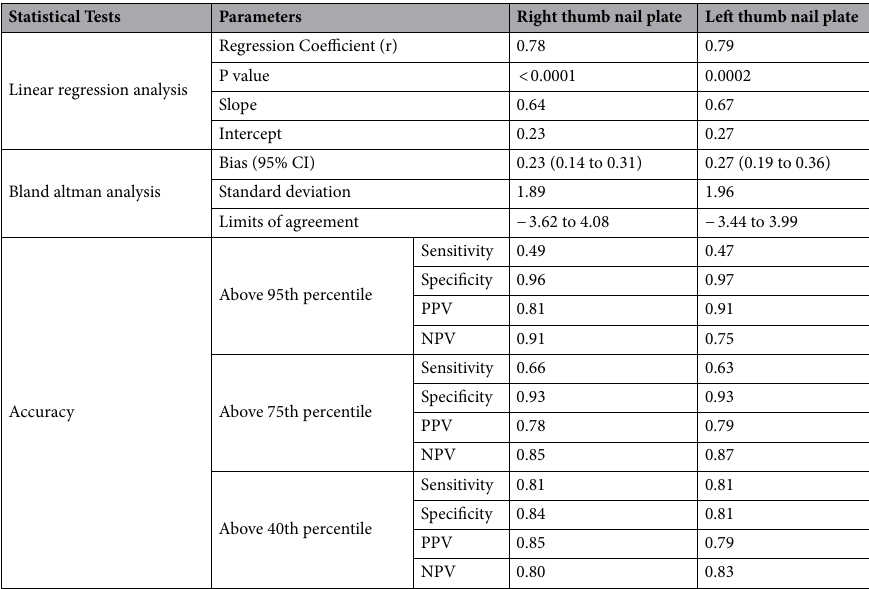
Table 5. The correlation between bilirubin values obtained from AJO-Neo and TSB along with predictive indices of AJO-Neo for the entire study population (N =